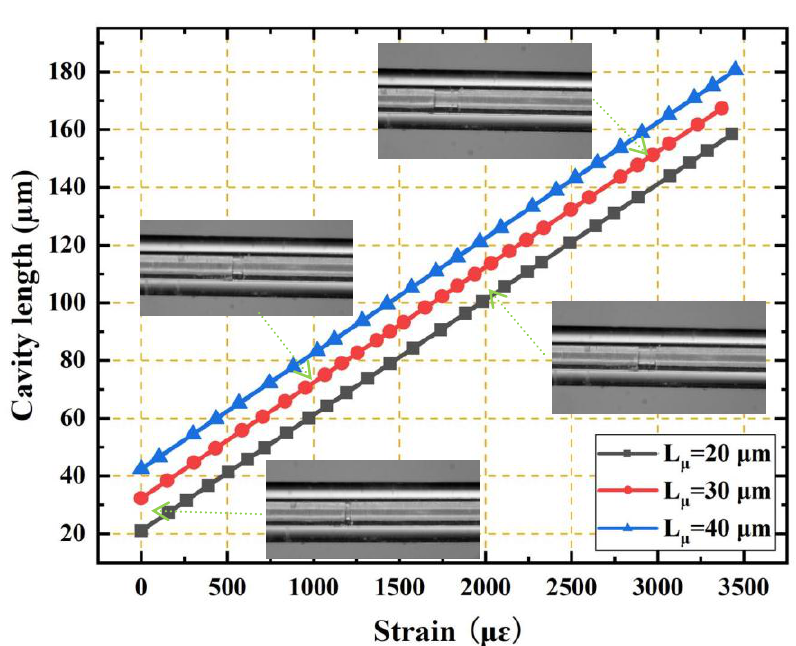
Figure 6. Relationships between the cavity length and the strain for three EFPI microcavity fiber-optic strain sensors with the same capillary lengths of 40 mm but di ff erent initial cavity lengths (20 µ m, 30 µ m, and 40 µ m). The cavity length–strain sensitivity was ~40.459 nm / µε , regardless of the initial cavity length. Micrographs of the EFPI microcavity fiber-optic strain sensor with the initial cavity length of 30 µ m under four di ff erent strains of 0, 1000, 2000 and 3000 µε are also given as insets.